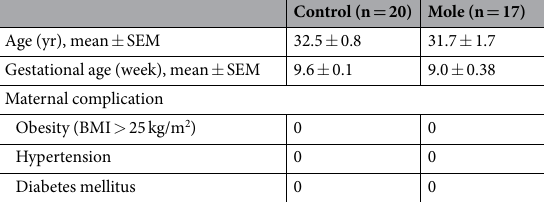
Table 1. Clinical characteristics for human